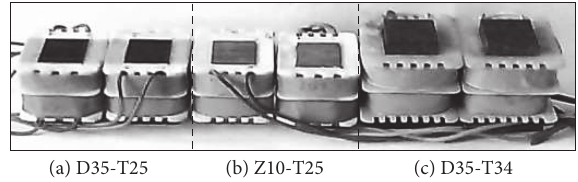
Figure 11: The material objects of electromagnets. Table 2: The maximum speed of blood pump under the condition of different electromagnet iron core.